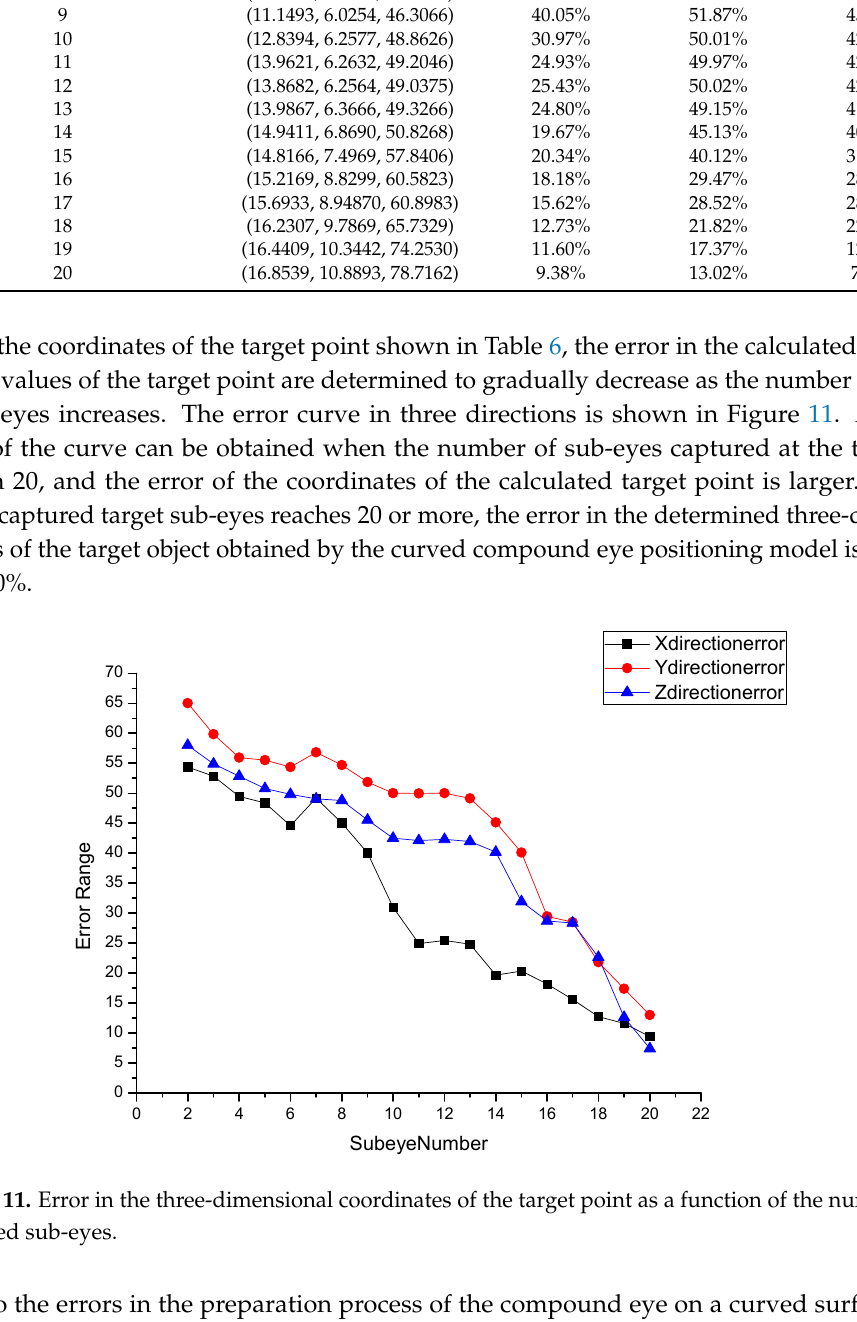
Table 6. Calculated target point coordinate values and errors.